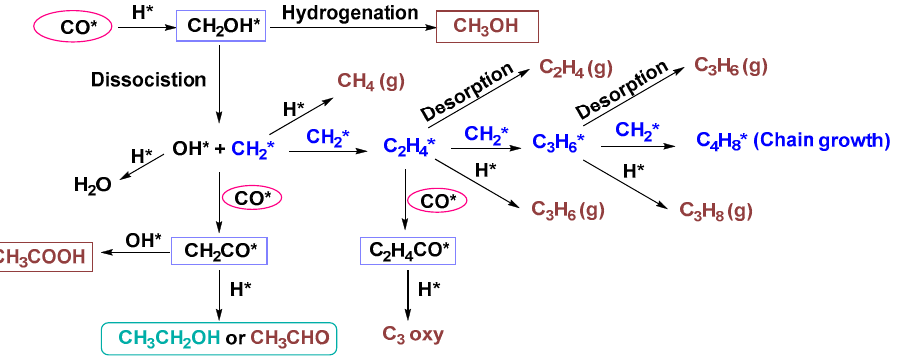
Figure 9. Possible pathways for the formation of hydrocarbon, methanol and C 2+ oxygenates from CO hydrogenation.